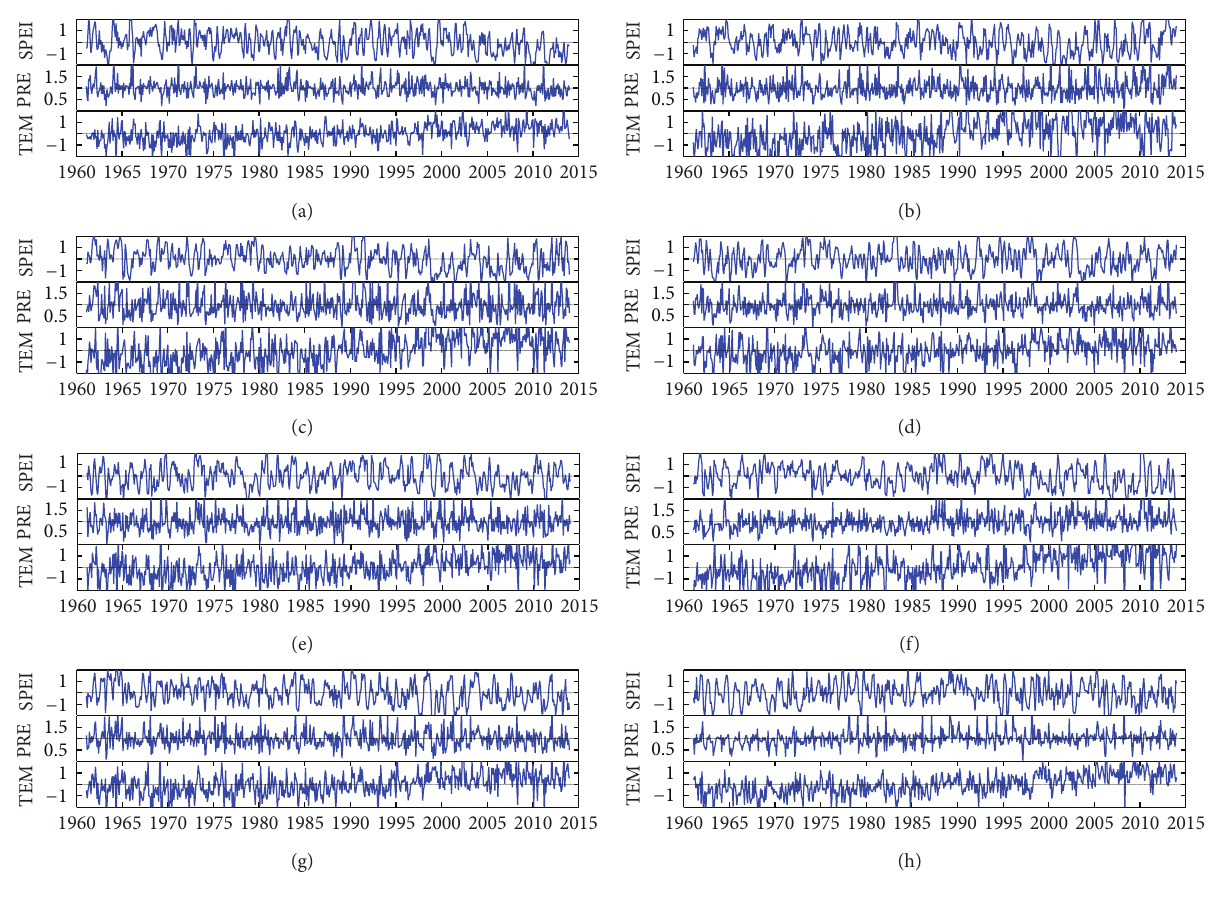
Figure 9: Temporal evolution of the 3-month SPEI in eight regions: (a) SW; (b) NE; (c) N; (d) SE; (e) YR; (f) NW; (g) C; (h)